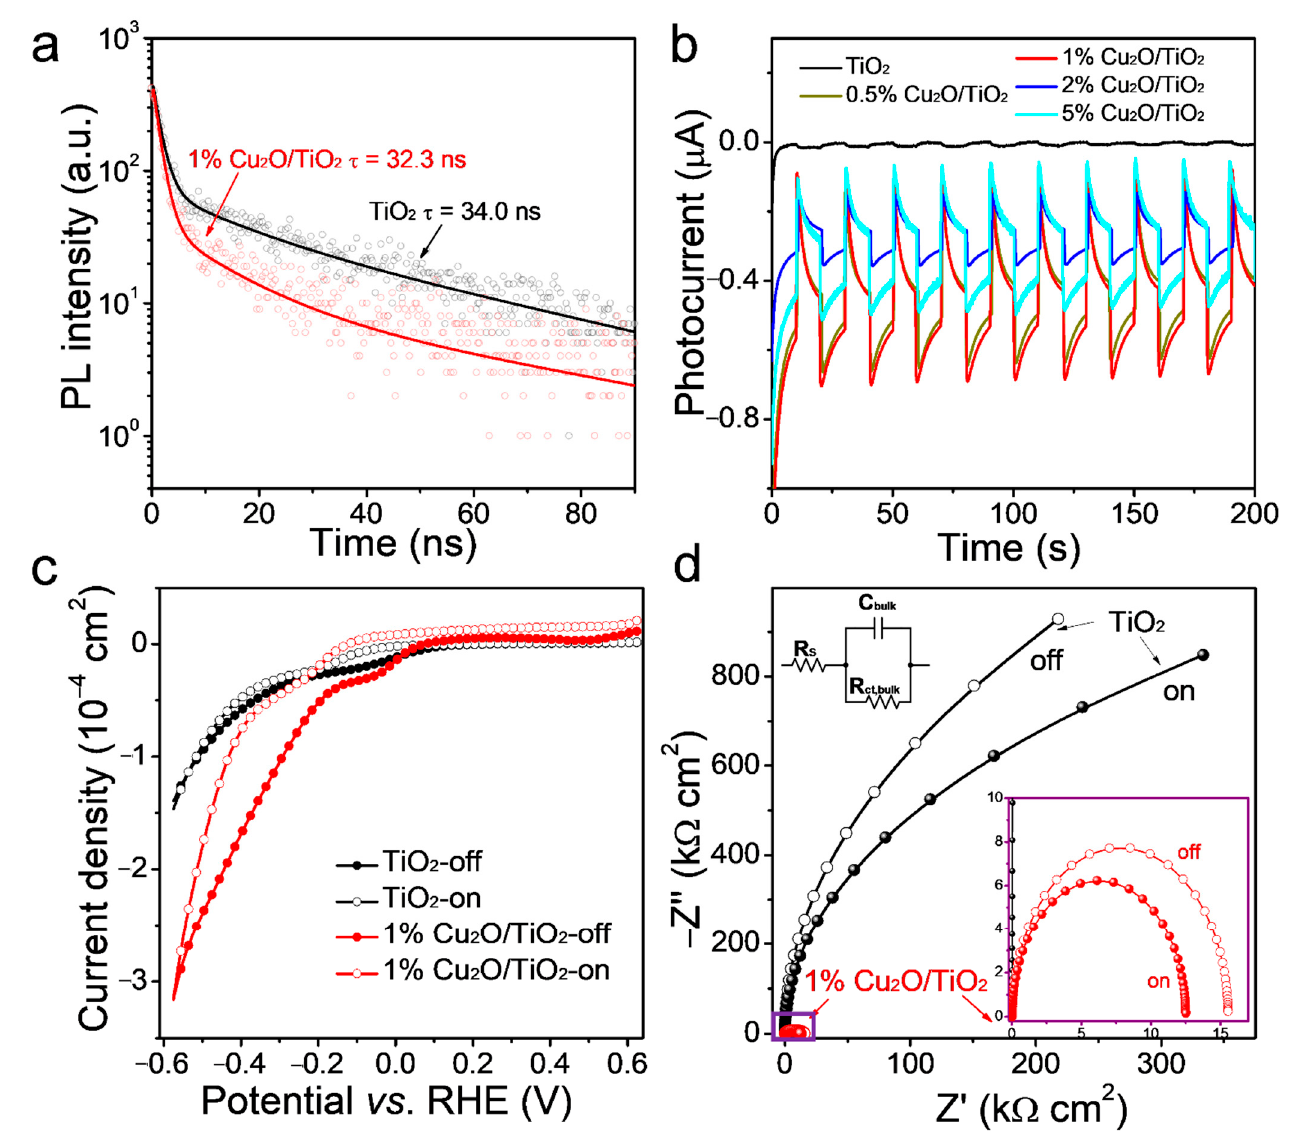
Figure 4. ( a ) TRPL decay of the TiO 2 and 1% Cu 2 O/TiO 2 composites. ( b ) Transient photocurrent response for TiO 2 and 0.5%, 1%, 2% and 5% Cu 2 O/TiO 2 composites. ( c ) Current density vs. potential (RHE) and ( d ) Nyquist plot with the EIS data obtained from TiO 2 and the 1% Cu 2 O/TiO 2 composite in the dark (off) and under illumination (on) at the AM1.5G solar power system 100 mW·cm − 2 light irradiation.